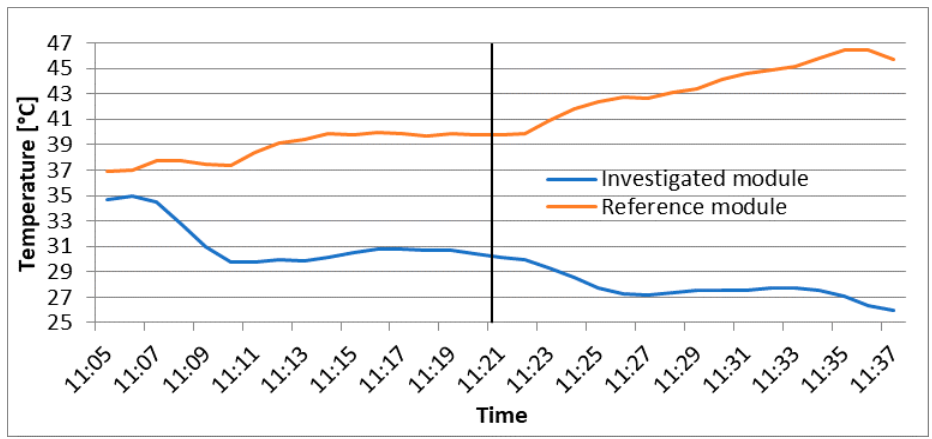
Figure 6. Power of PV modules during the comparative 30-min test.